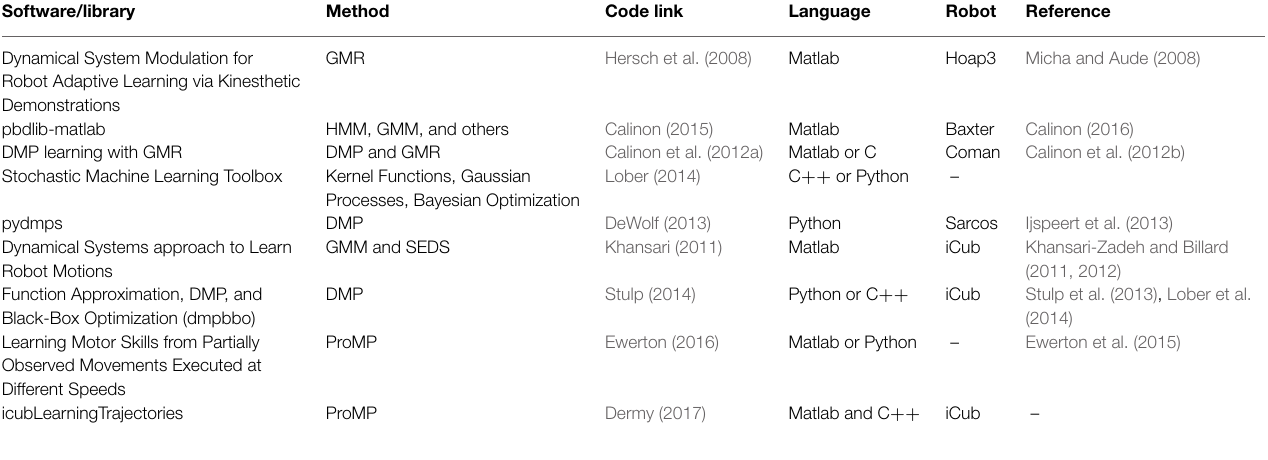
TABLE 1 | Open-source software libraries implementing movement primitives and their application to different known robots.